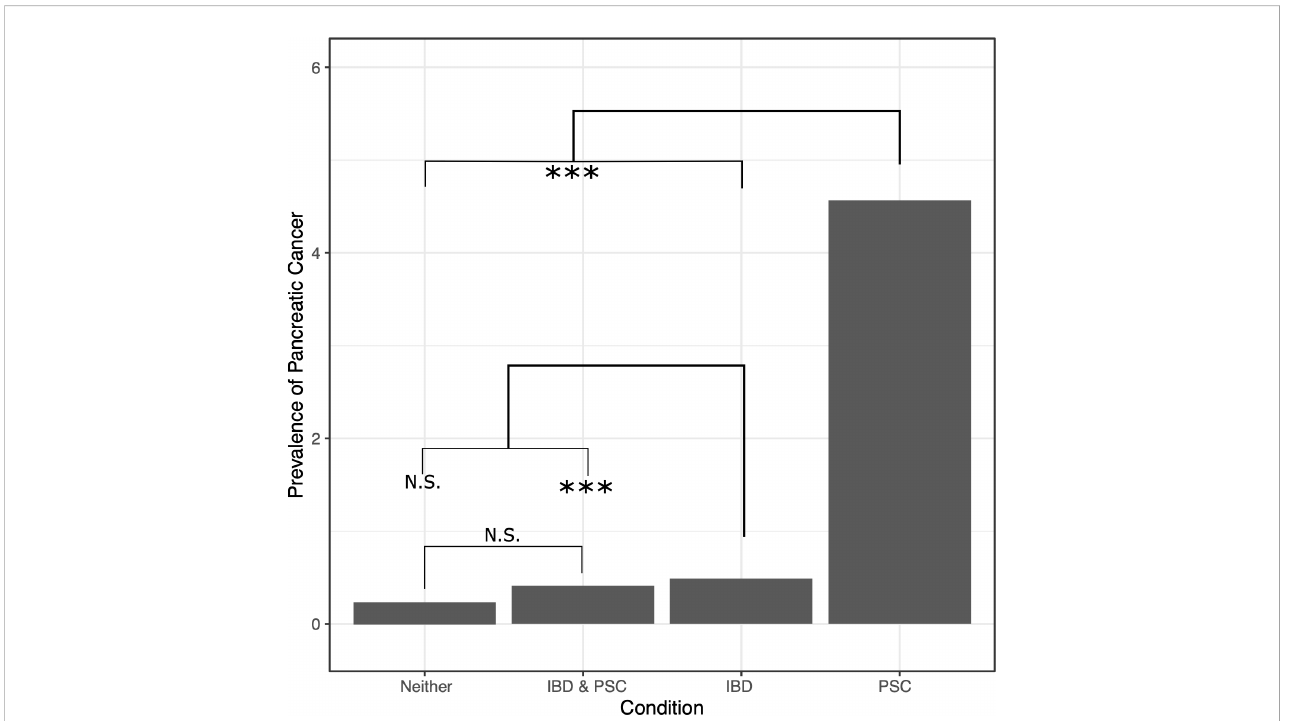
FIGURE 1 Prevalence (in population percentage) of pancreatic cancer in patients with neither PSC nor IBD, both PSC and IBD, IBD only, and PSC only. NS, not signi fi cant, *** = p-value ≤